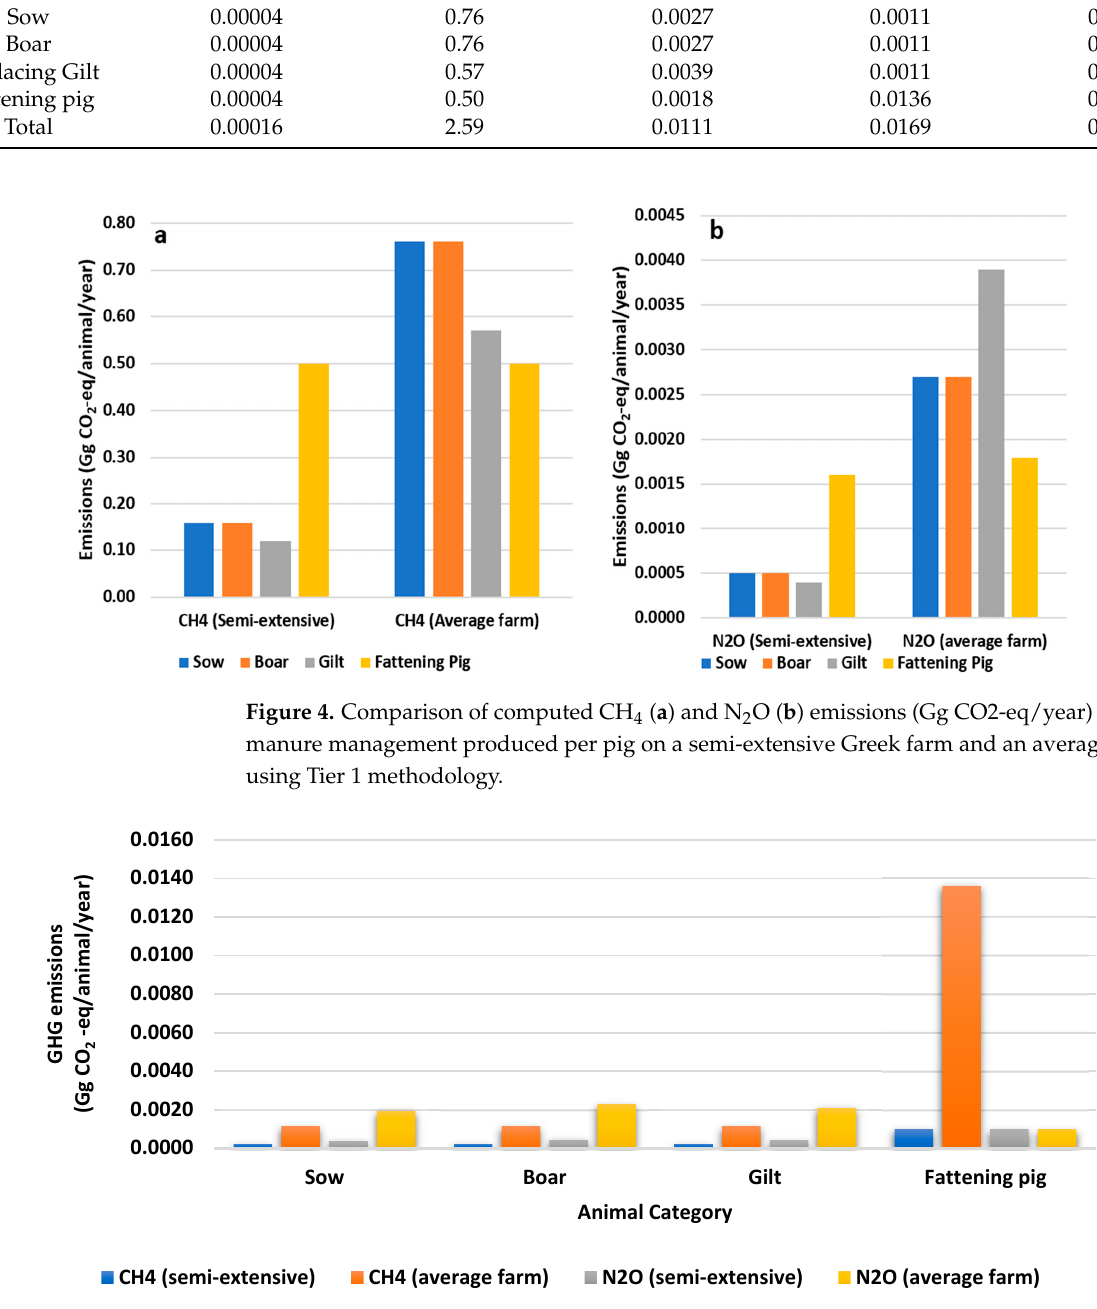
Figure 5. Comparison of computed CH 4 and N 2 O emissions (Gg CO 2 -eq/year) from manure management produced per pig on a semi-extensive Greek farm and an average Greek farm using Tier 2 methodology .